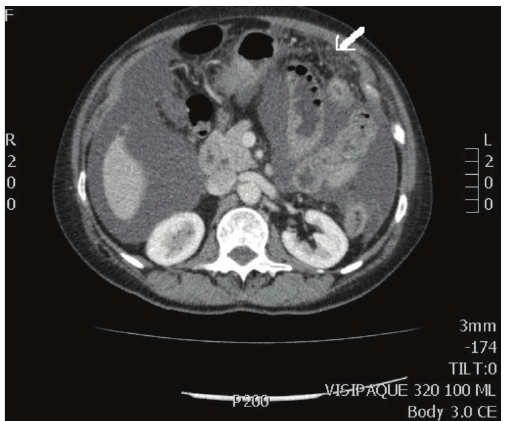
Figure 1: CT scan of the abdomen and pelvis with contrast showing heterogeneous fat/soft-tissue density within the greater omentum (see white arrow). There is also extensive ascites.